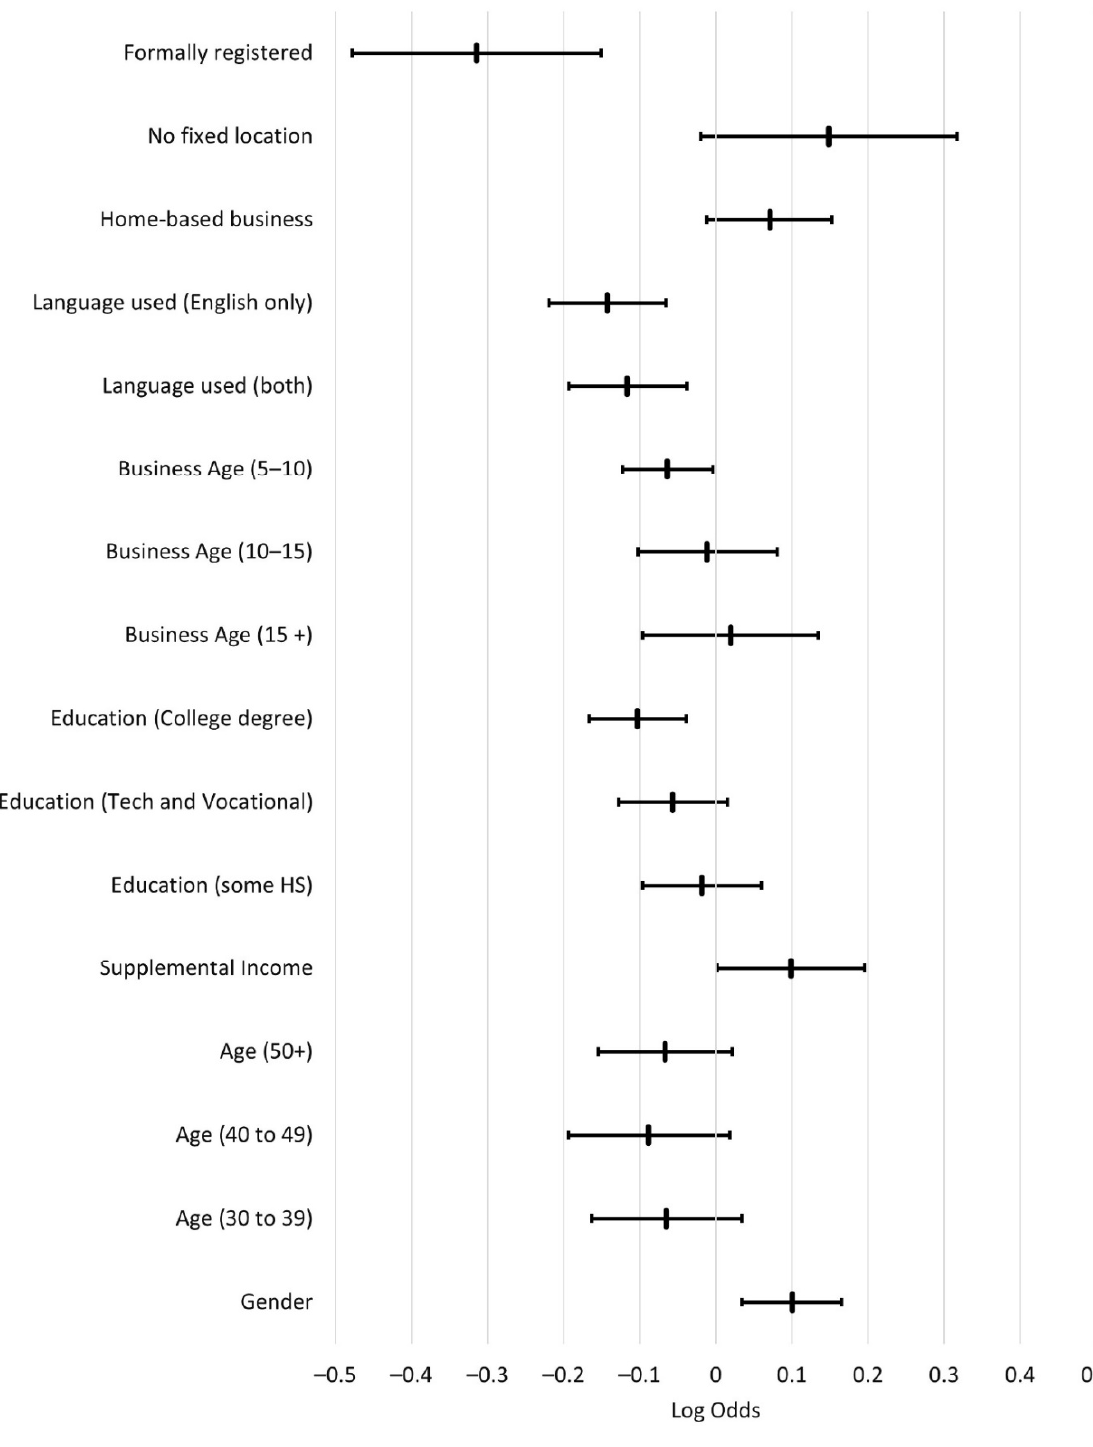
Figure 1. Coefficient estimates and 95% confidence intervals for the low sales category.